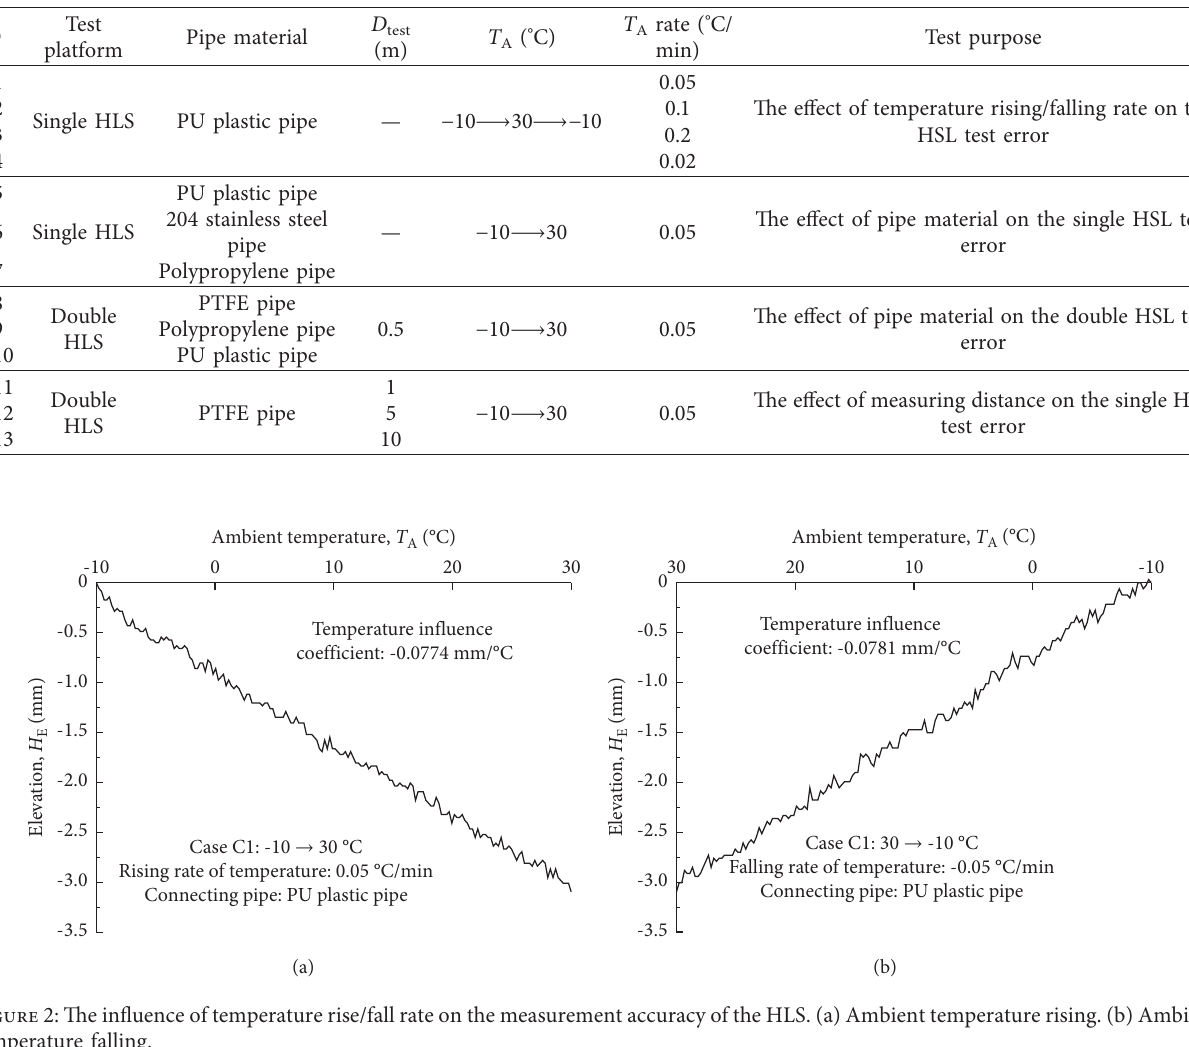
Table 4: The influence of ambient temperature on the measurement accuracy of the HLS.